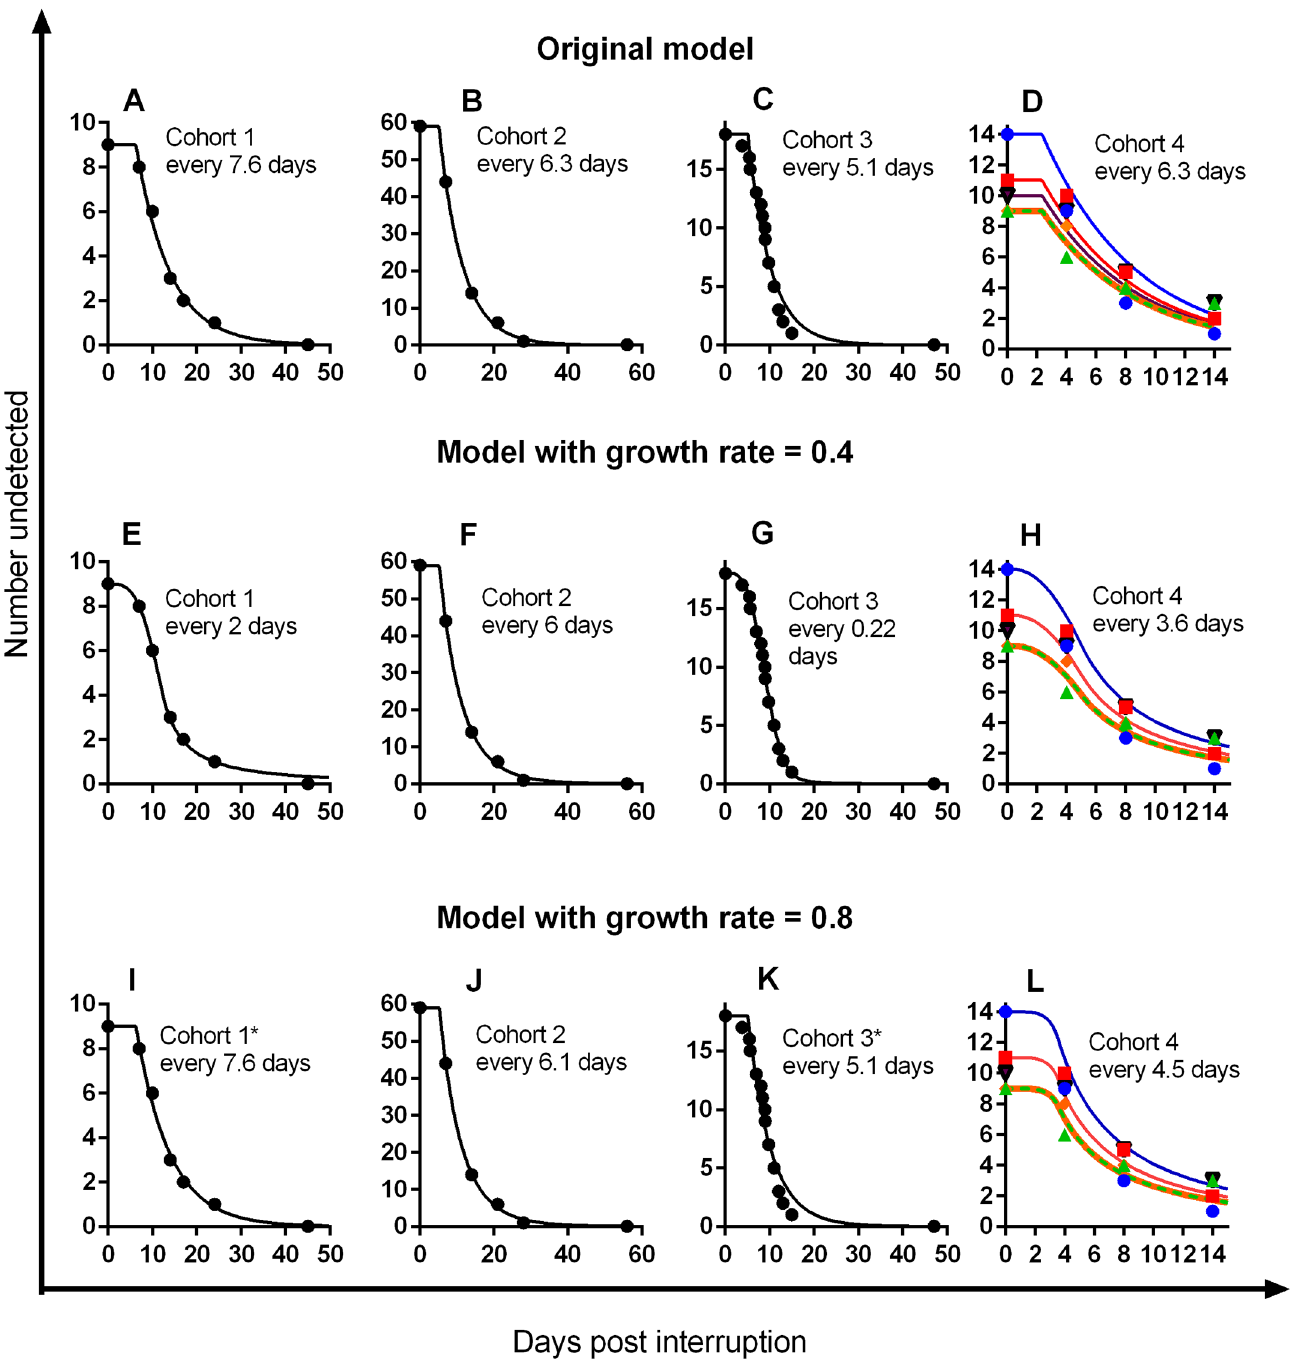
Fig 1. Estimating HIV reactivation rate using different models. The figure compares the fitting of the best-fit reactivation rate to each of the four cohorts using the original simple two-parameter model (panels A – D) as well as the more complex model proposed by Hill et al. that incorporates multiple reactivation events and a distribution in reactivation rates. The latter is fitted using a washout time of 0 days and either Hill et al. ’ s proposed slow viral growth rate ( g = 0.4/day) (panels E – H) or a more realistic growth rate estimated from cohort 1 ( g = 0.8/day) (panels I – L). In each case, the initial viral load ( V 0 ) and the mean and standard deviation of the reactivation rate is fitted. The average time between reactivation events is indicated for each cohort. Only for cohort 3, with a low growth rate (panel g), is estimated reactivation rate more frequent than once every 2 days. * Note: although a distribution in reactivation rates was fitted, the best fit model had a standard deviation of